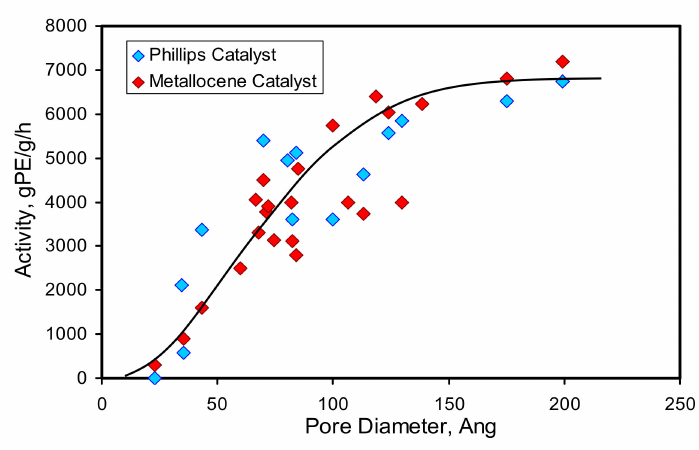
Figure 3. Cogelled silica-alumina were made into Phillips or metallocene